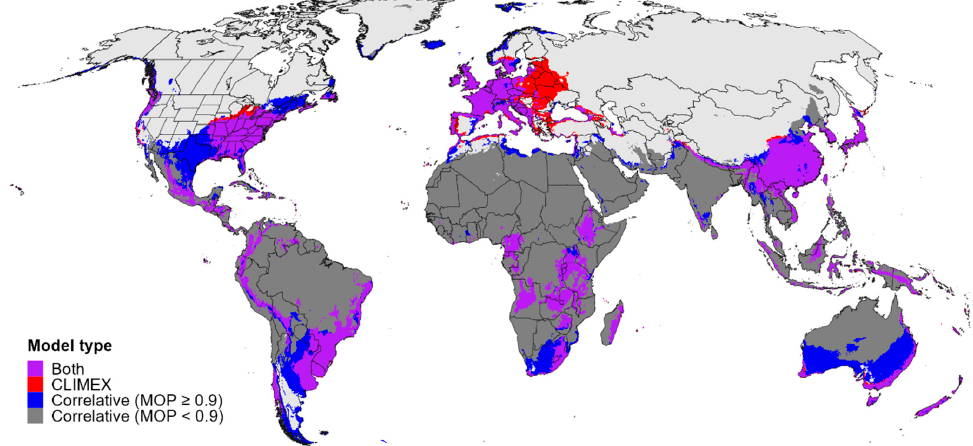
Figure 9. Map of the global potential distribution for Calonectria pseudonaviculata . Areas of overlap in the potential distribution according to the CLIMEX model and the ensemble correlative model (purple shading) are shown in comparison to areas that were included in the potential distribution by only the CLIMEX model (red shading), or by the ensemble correlative model in areas with similar climates to the model calibration area (MOP values ≥ 0.9; blue shading). Correlative model predic- tions for areas that had dissimilar climates to the calibration area (MOP values <0.9) and that were not included in CLIMEX’s estimate of the potential distribution (dark gray shading) were not inter- preted.